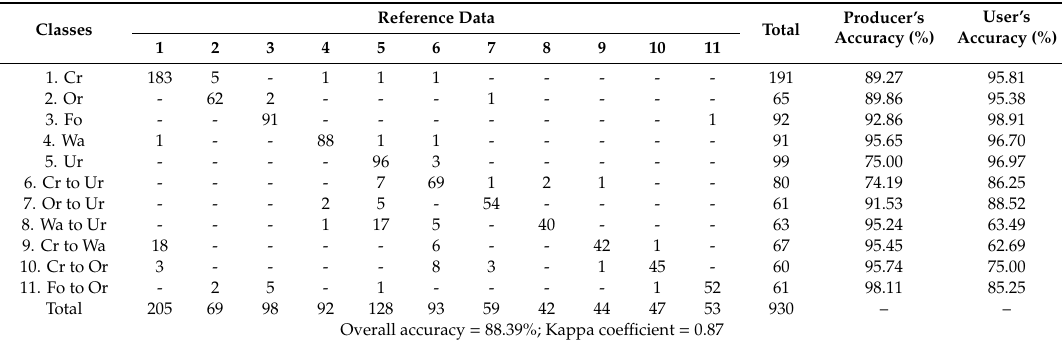
Table 9. Confusion matrix of the PCA-based method, 1996–2000.